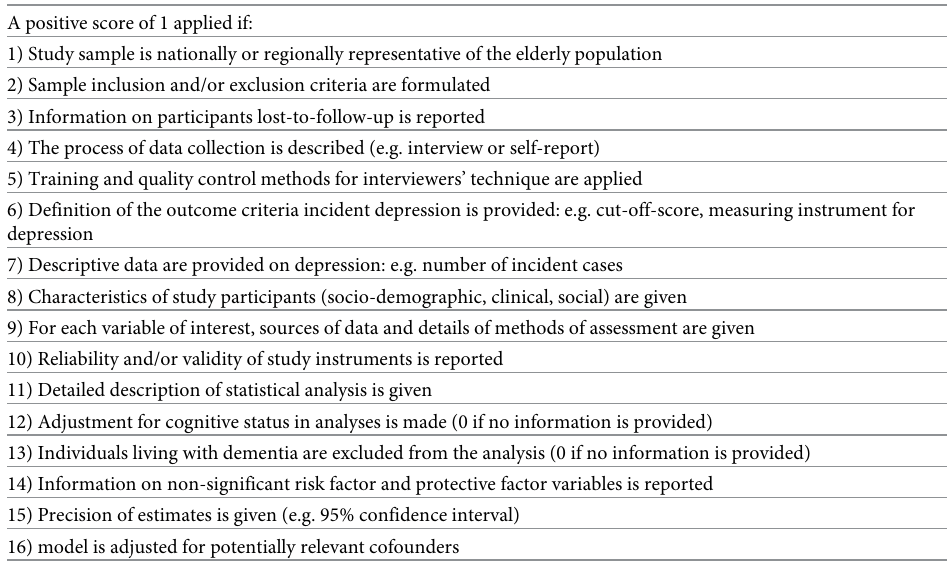
Table 1. Criteria for assessing methodological